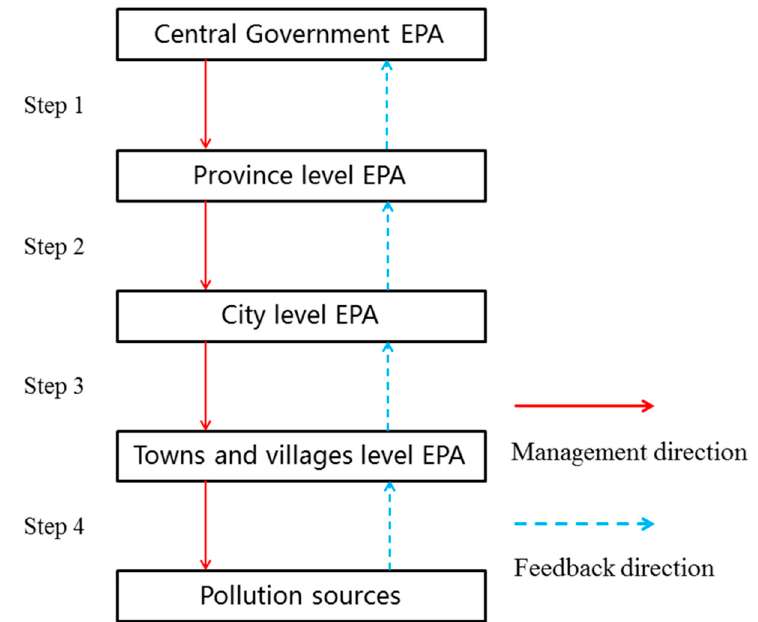
Figure 1. The cascade pollution discharge management structure in China: The solid red lines are the management decision making and the blue dashed lines are the cumulative feedback.